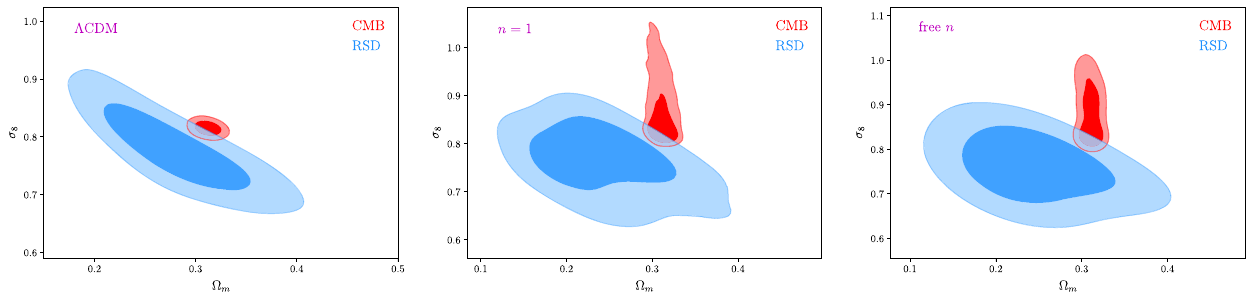
Fig. 2 The constrained 2-dimensional parameter spaces ( (cid:11) m , σ 8 ) from the “C” (red) and “R” (blue) datasets are shown for (cid:3) CDM, HS f ( R ) models with n = 1 and free n ,